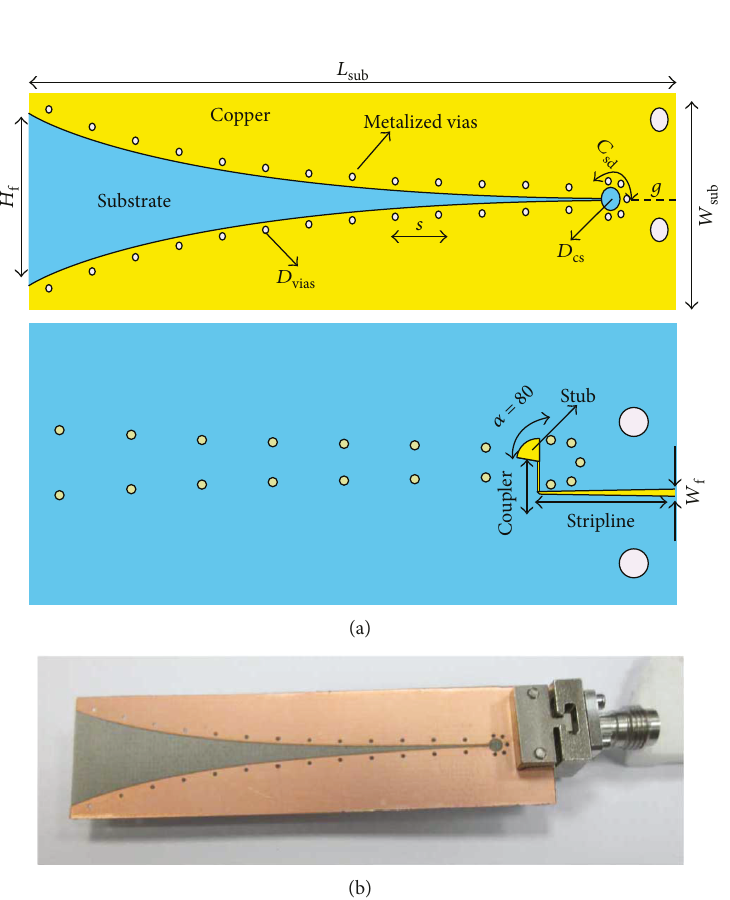
Figure 1: (a) Geometric design (top and bottom) of the proposed single-element SCVA. (b) Realized prototype of SCVA (top